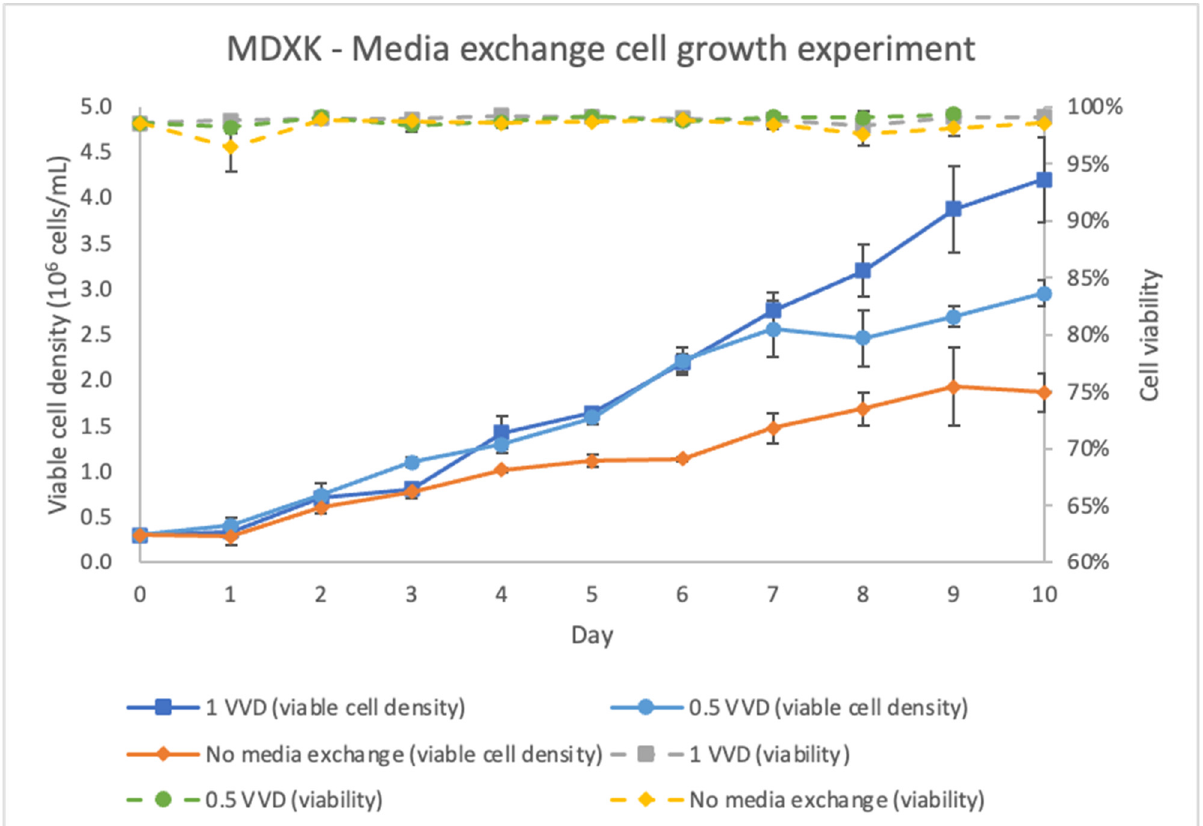
Figure 3. Viable cell density and cell viability in shake flasks with a media exchange at 0–1 vessel volume per day (VVD).